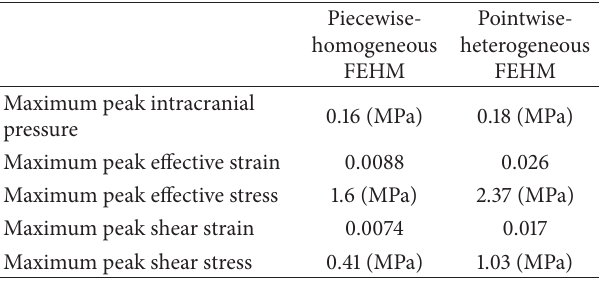
Table 3: Comparison of piecewise-homogeneous and pointwise- heterogeneous FEHM.